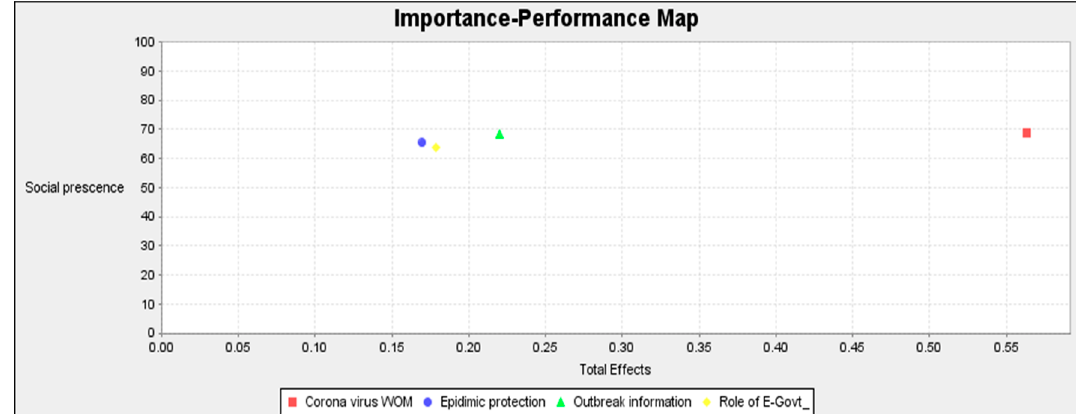
Figure 7. Impact performance map analysis (IPMA).